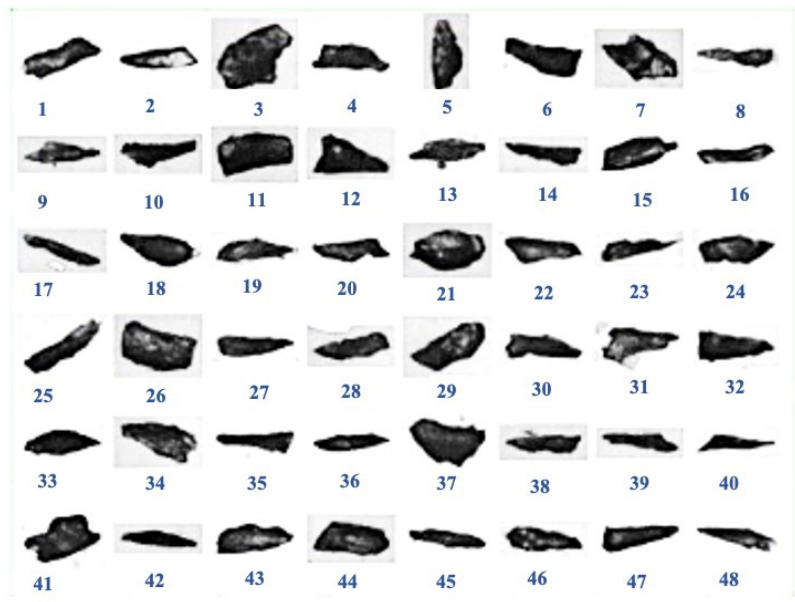
Figure 18. DIA images of ball-milled quartz particles.